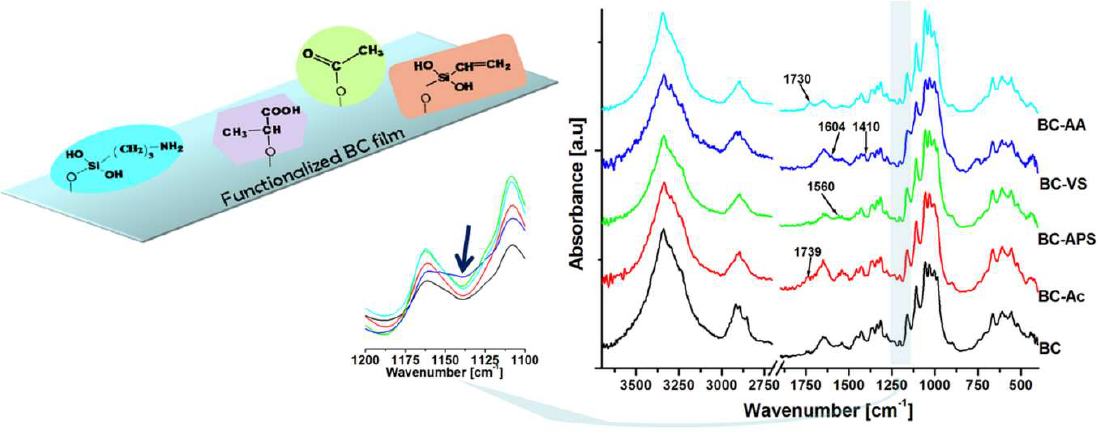
Figure 6. FTIR spectra of pristine and treated BC; detail—1200–1100 cm −1 .